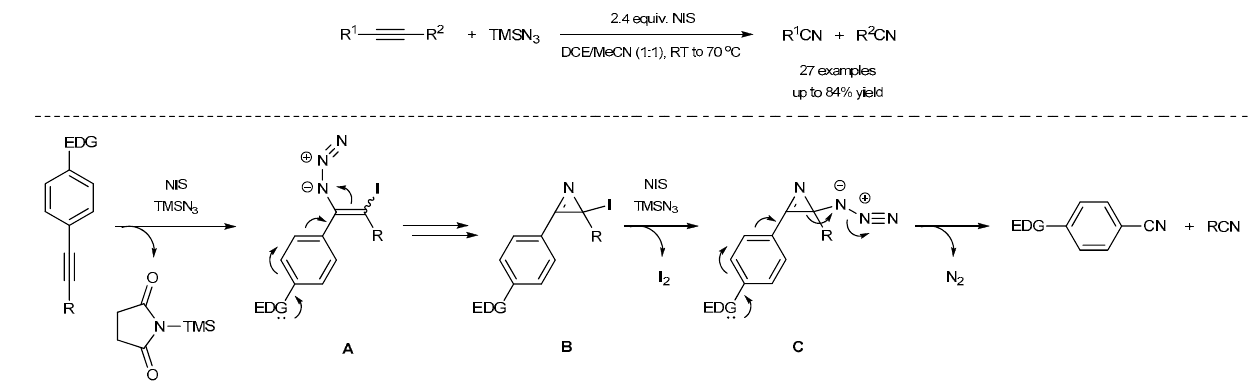
Scheme 1. Triple C ≡ C bond cleavage reported by Yanada and co-workers [22] (top), and their proposed mechanism (bottom).